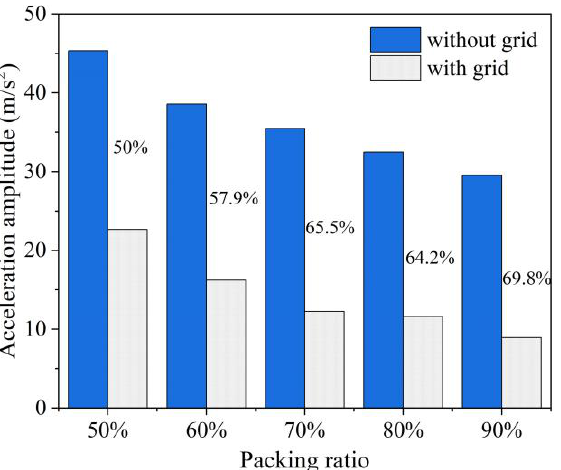
Figure 3. Vibration response of cantilever beam with and without obstacle grid particle dampers .